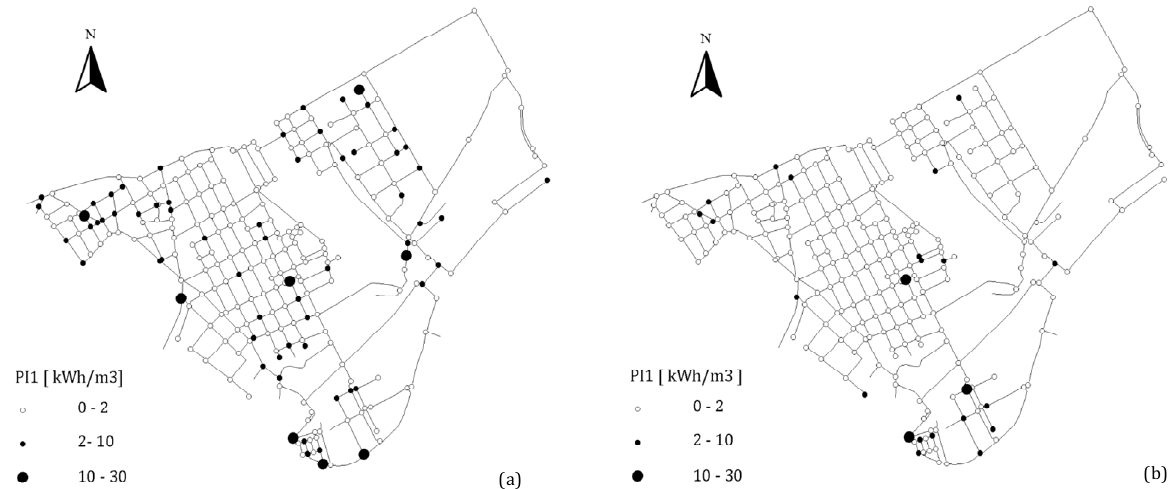
Figure 6. PI1 node values: ( a ) intermittent distribution with underground tank and ( b ) intermittent distribution with rooftop tank.